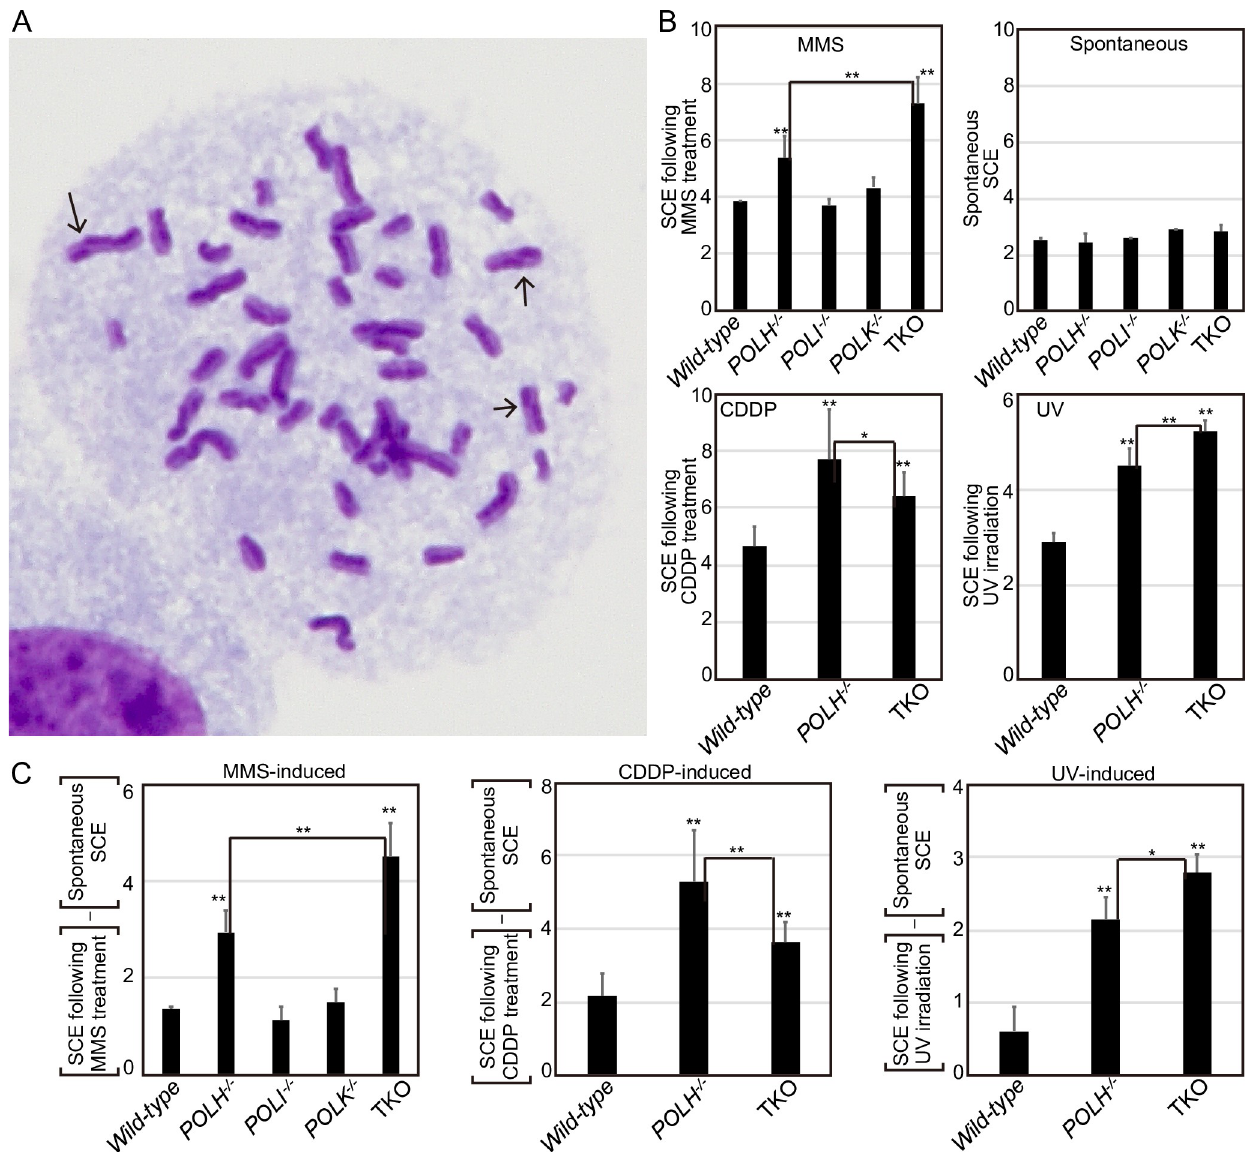
Fig 5. Increased number of SCEs due to TLS failure across DNA damage induced by MMS, CDDP, or UV. (A) Representative image showing SCEs in TK6 cells. (B) TK6 cells were continuously cultured in a medium containing BrdU (10 μ M) and either CDDP (0.2 μ M) or MMS (1 μ g/mL) for 24 h. For UV irradiation, cells were exposed to UV (1 J/m 2 ), then cultured in a medium containing BrdU for 24 h. Cells were treated with colcemid (0.1 μ g/ml) to enrich for mitotic cells for the last 3 h of incubation. The number of spontaneous and induced SCEs in the macrochromosomes of 50 metaphase cells was scored at least two times. Error bars represent standard deviations from at least two independent analyses. Each data set is shown in S8 Fig. (C) The number of MMS-, CDDP-, or UV-induced SCEs was calculated by subtracting the number of spontaneous SCEs. Error bars represent standard deviations from at least two independent analyses. The p -value was calculated by Student’s t -test using all scored SCE data ( � p < 0.05, �� p < 0.01).